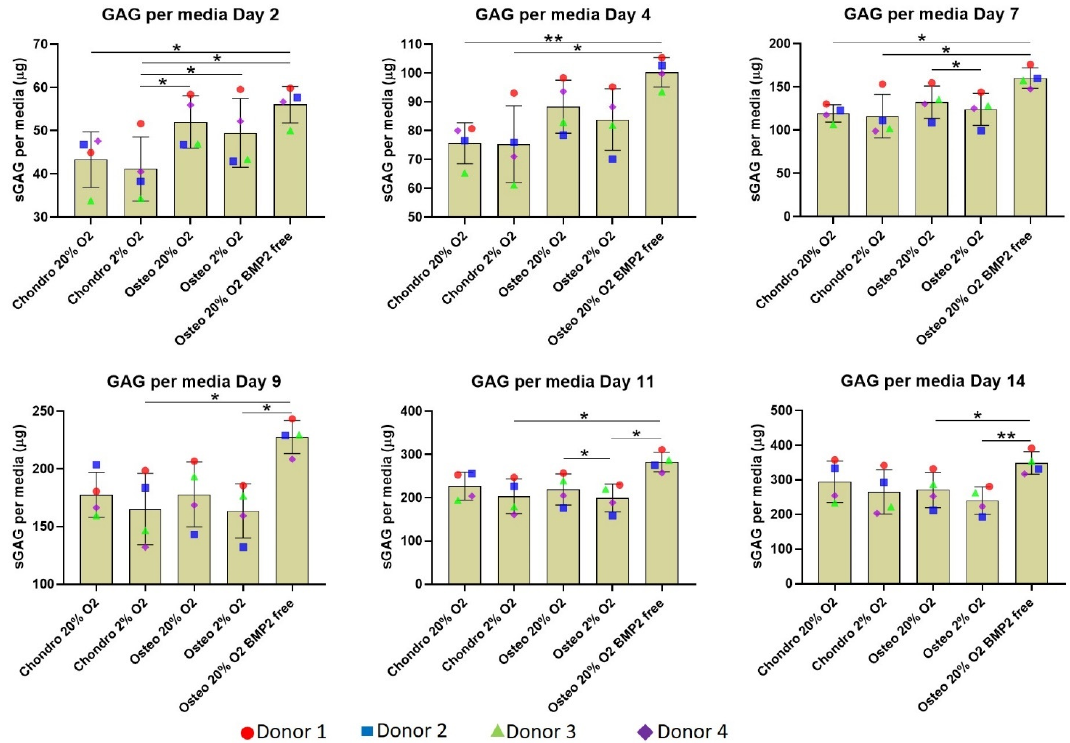
Figure 5. GAG produced and released into culture media from scaffolds over 2 weeks in culture. In the first 7 days, the osteogenically differentiated groups released significantly more GAG into the culture media compared with the chondro- genically differentiated constructs. The absence of BMP2 in the osteogenic media kept the media GAG higher until day 14. sGAG content in culture medium was determined spectrophotometrically following reaction with 1.9-dimethylmethylene blue (DMMB) pH 3. Values represent the mean ± SD of three independent hBMSC donors in experimental quadruplicate or quintuplicate. Statistical significance was defined as * p < 0.05 and ** p < 0.01 .